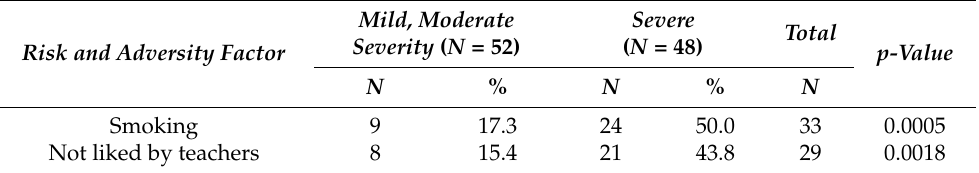
Table 6. Association between certain risk and adversity factors and severity of symptoms. Mild, Risk and Adversity Factor